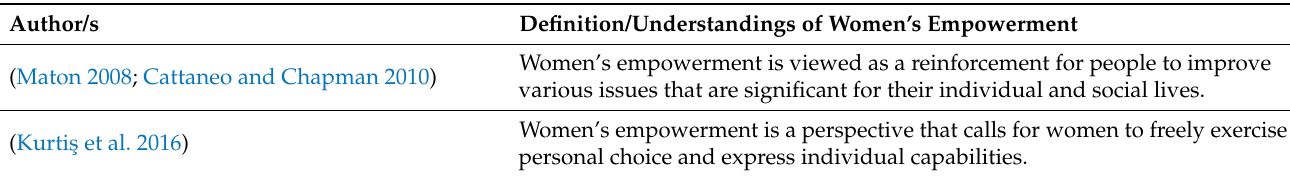
Table 1. Definitions of women’s